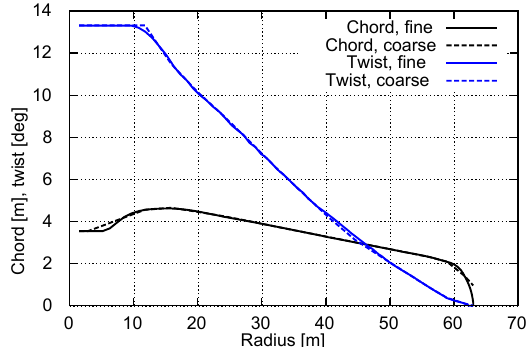
Figure 6. Coarse and fine blade geometry for the NREL 5MW ref- erence turbine. The coarse definition is a typical geometry definition for BEM-based computations. The finer geometry is smoothed for use in computational fluid dynamics and free-wake codes.